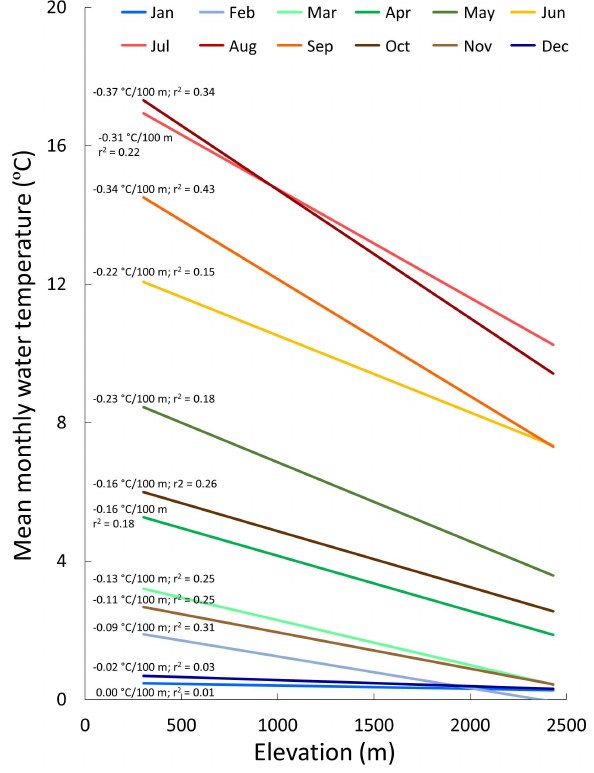
Figure 3. Linear regression trends between elevation and mean monthly temperatures at 226 river and stream sites during 2013 (data values are not shown for clarity). Values next to the trend lines are regression slopes and r 2 values from the regressions.